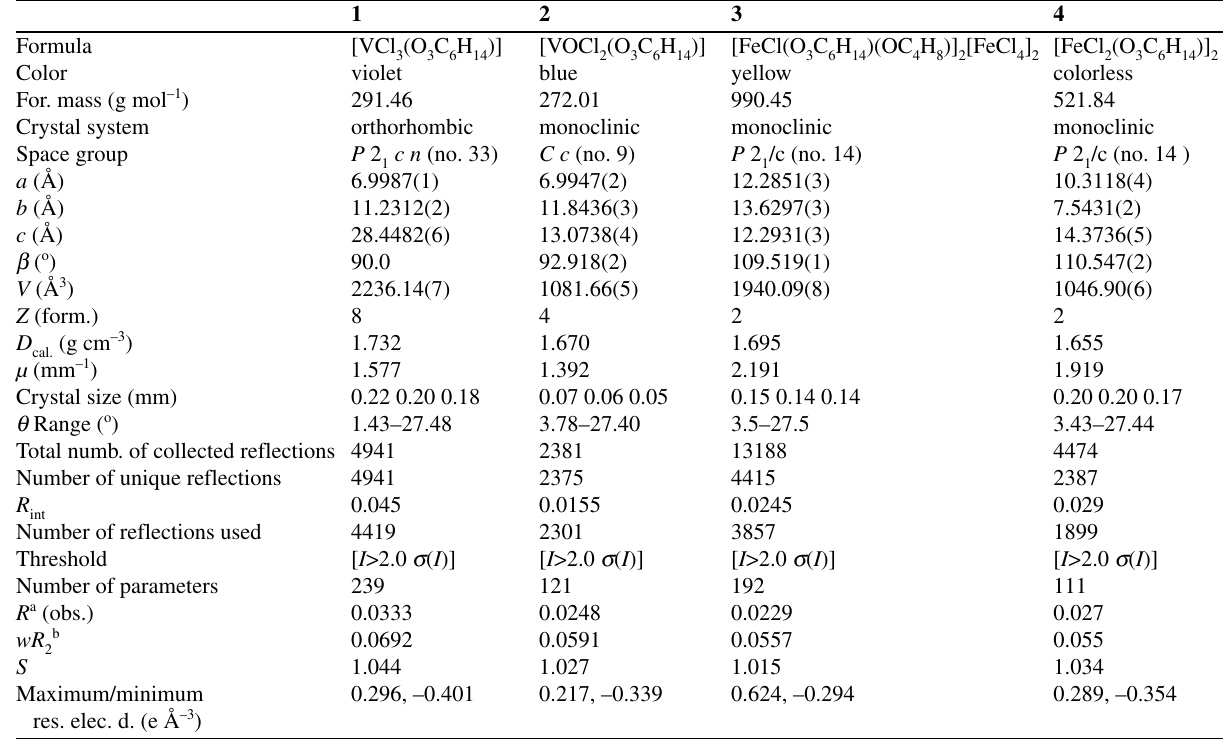
[ FeCl ] , and 4 , [ FeCl 2 4 2